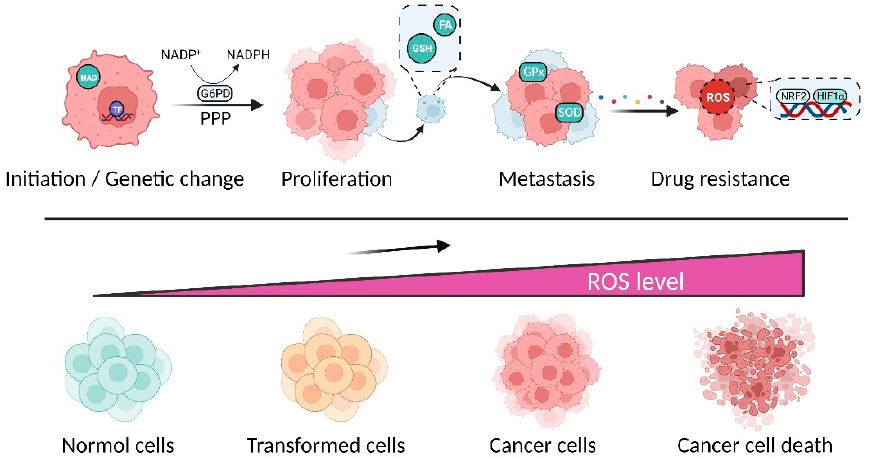
Figure 2. Redox homeostasis involved in cancer evolution. Reactive oxygen species (ROS) almost participate in all aspects of cancer, including initiation, proliferation, metastasis, and drug re- sistance. Cancer cells evolved a set of robust antioxidant system, including reducing power (e.g., NADPH), non-enzymatic and enzymatic antioxidants, and transcription factors, for adapting to ox- idative stress.